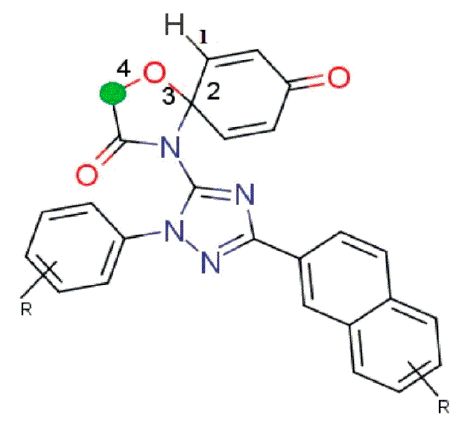
Figure 4. Illustration for molecular descriptor fHringC4B .